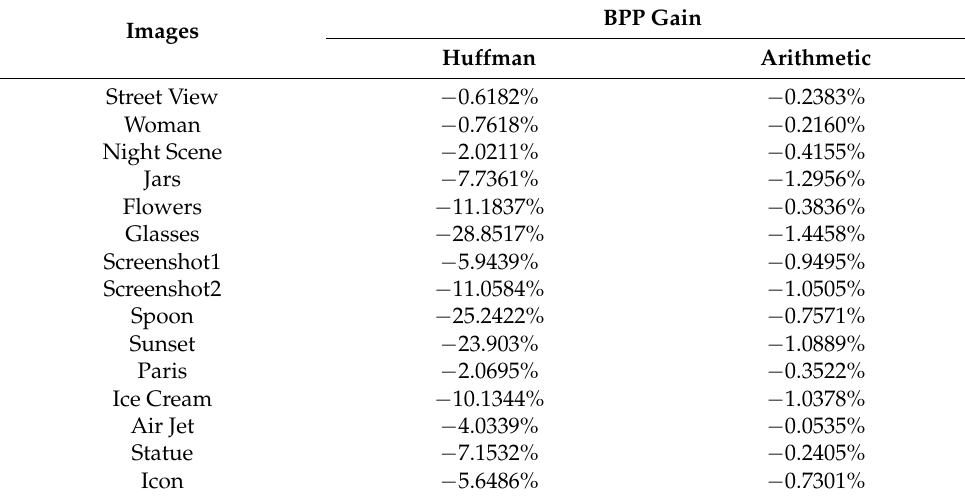
Table 1. Calculated Bjontegraad’s metric for BPP.